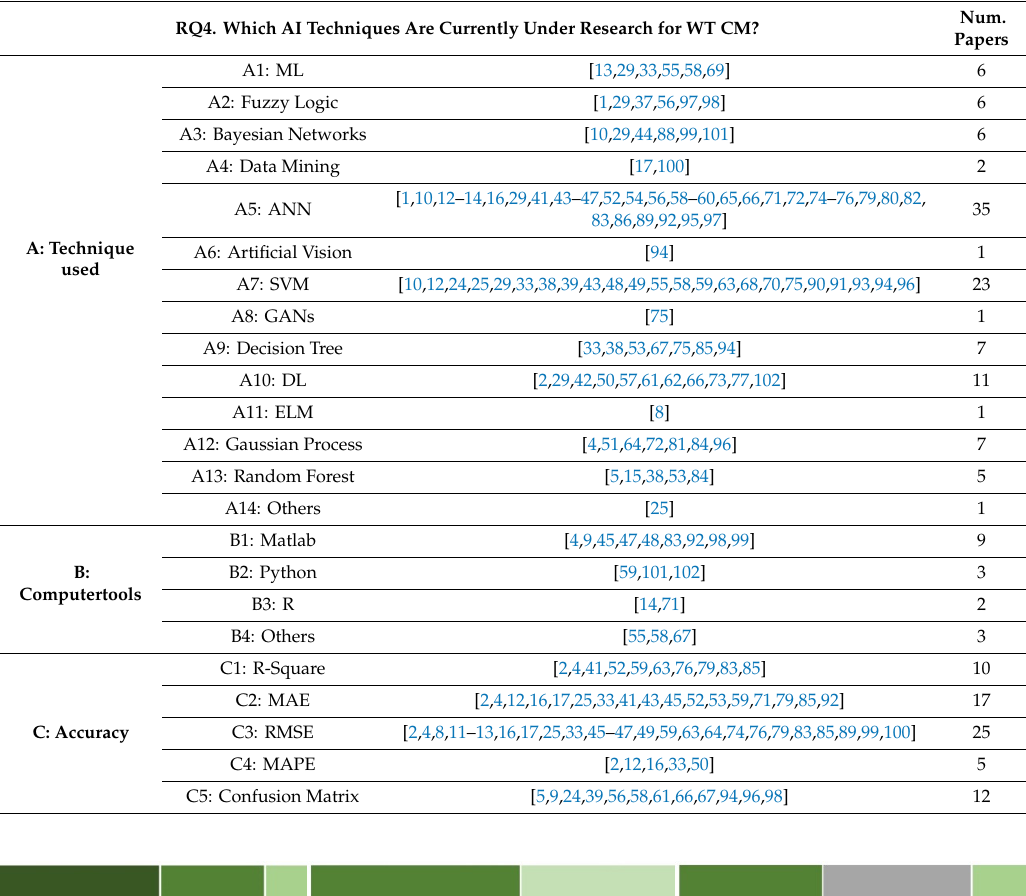
Table 8. Research articles on artificial intelligence (AI) techniques for CM of WT. RQ4. Which AI Techniques Are Currently Under Research for WT CM?